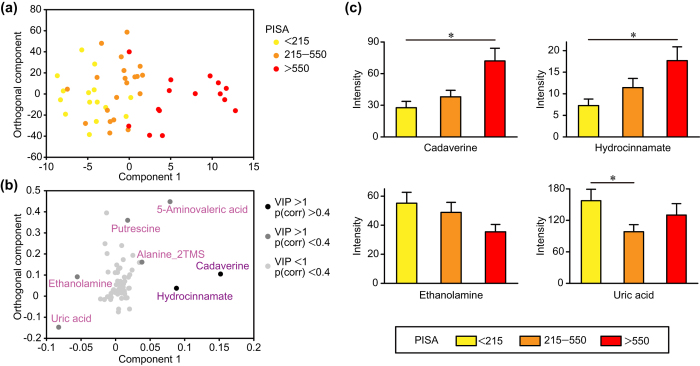
Salivary metabolites associated with periodontal inflammatory status.(a) Score plot of OPLS model for PISA. Each point represents a single pre-debridement saliva sample from each of the 50 subjects, color-coded based on PISA value. Component 1 denotes the variance of the salivary metabolic profile related to PISA. Variance unrelated to PISA was filtered into the orthogonal component. (b) Loading plot of OPLS model for PISA. Each point represents a single metabolite and its position corresponds to the PISA value, with those on the right associated with higher PISA. Shading of circles corresponds to significance in construction of the model, with darker circles indicating a stronger contribution. (c) Differential metabolite abundance in saliva based on PISA value. Data are presented as the mean ± SE and a Kruskal-Wallis rank sum test was used for statistical analysis. *p < 0.05.